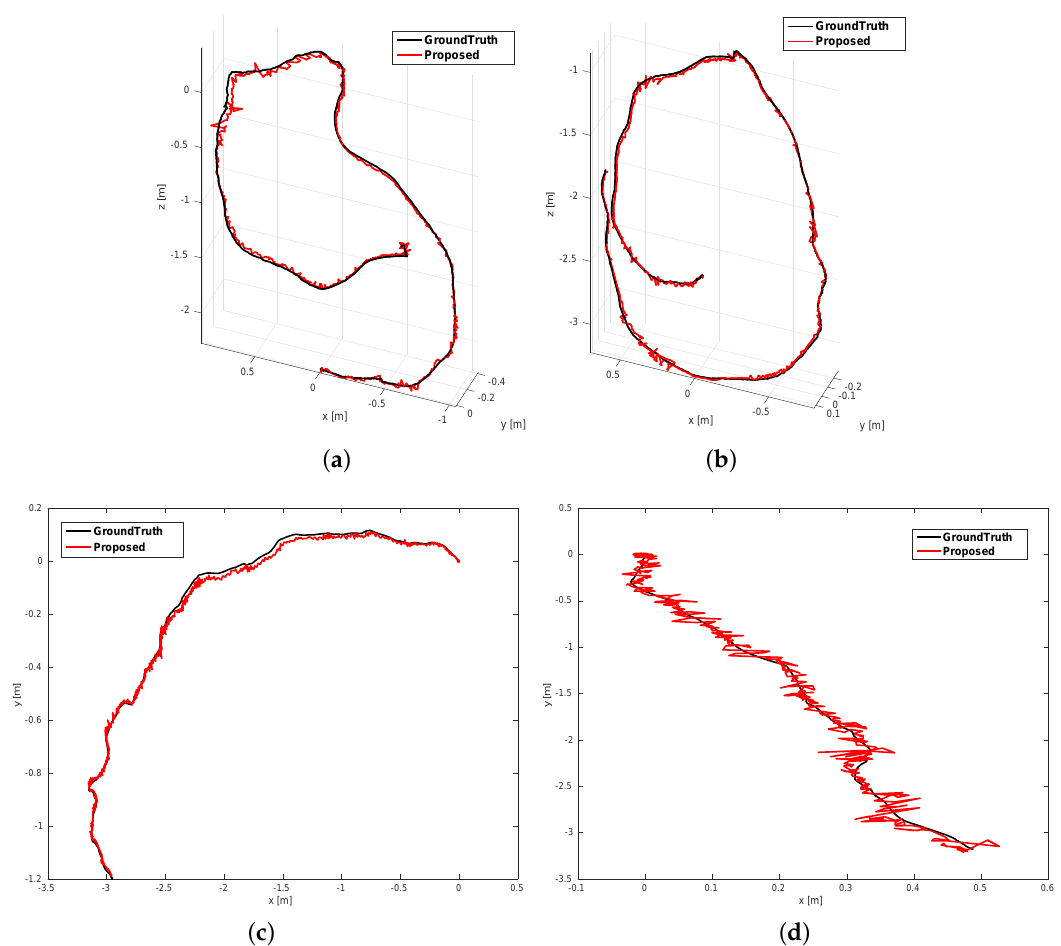
Figure 10. Estimated trajectories with the proposed (red) and ground truth (black) on four sequences: ( a ) Living Room2, ( b ) Office Room 3, ( c ) fr3_struc_tex, ( d )